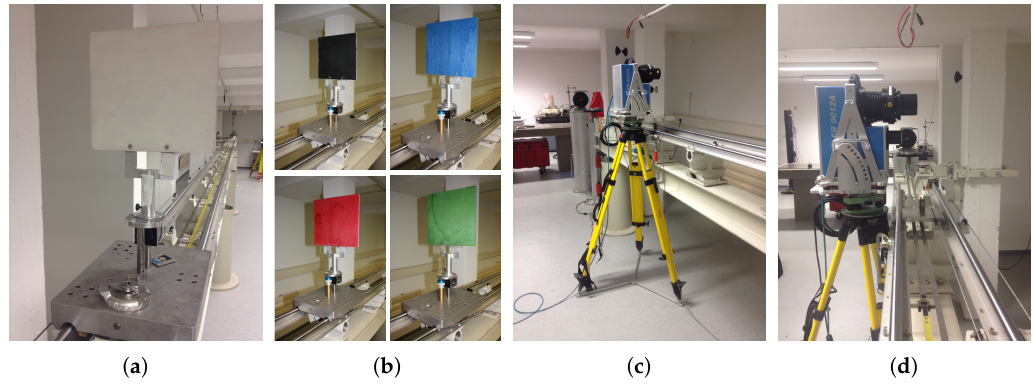
Figure 4. ( a , b ): white and colored planar targets that were scanned with the Z + F Profiler 9012A; ( c , d ): Z + F Profiler 9012A on a tripod next to the railbound comparator